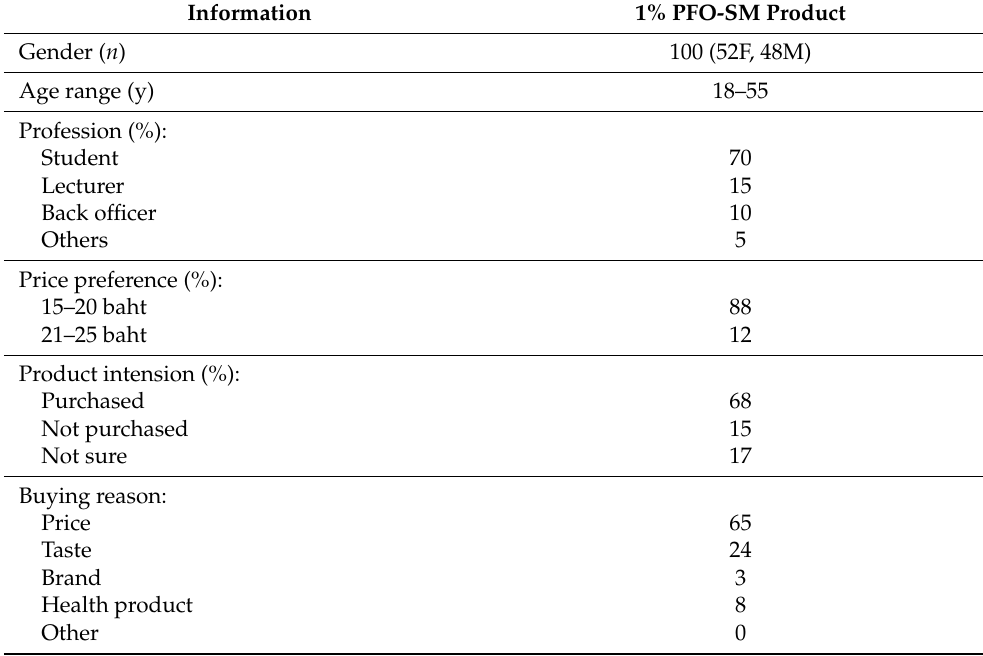
Table 2. Demographic data of healthy volunteers who assessed their level of satisfaction of the 1% PFO-SM drink for 30 d. Information